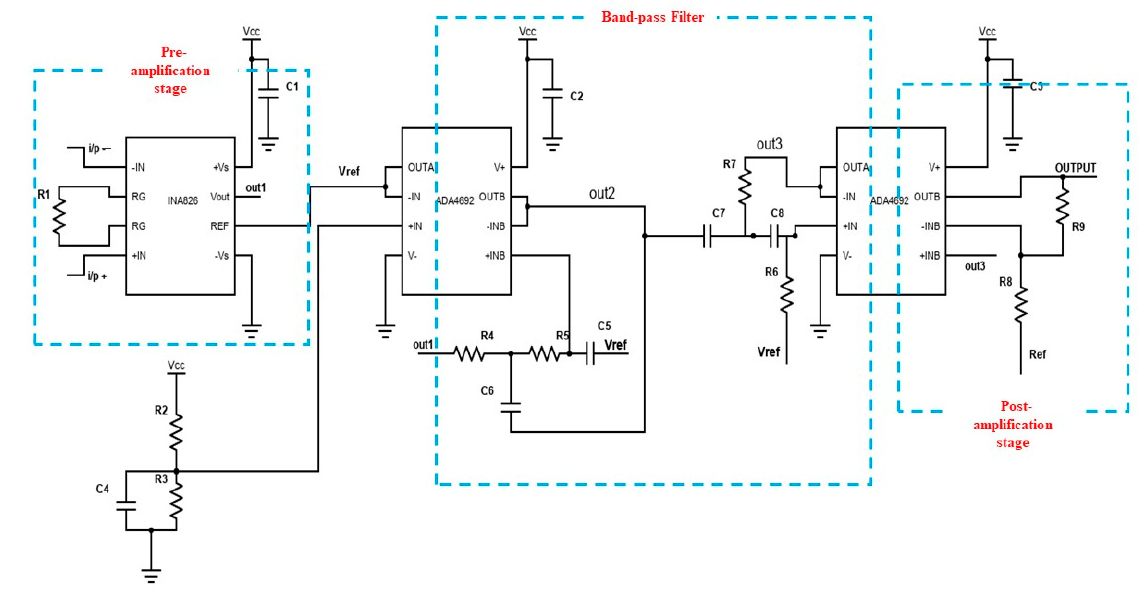
Figure 3. Circuit diagram of the neural sensor.